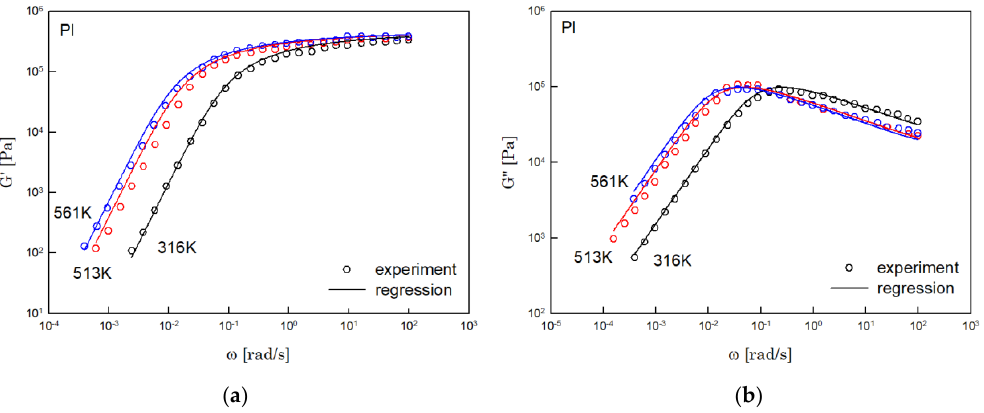
Figure 4. Comparison the regression results (lines) with the experimental data (symbols) of ( a ) stor- age modulus and ( b ) loss modulus of PBD. These experimental data are measured by Baumgaertel and Winter [16].